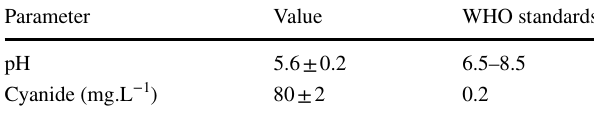
Table 1 Properties of Cassava Wastewater Sample